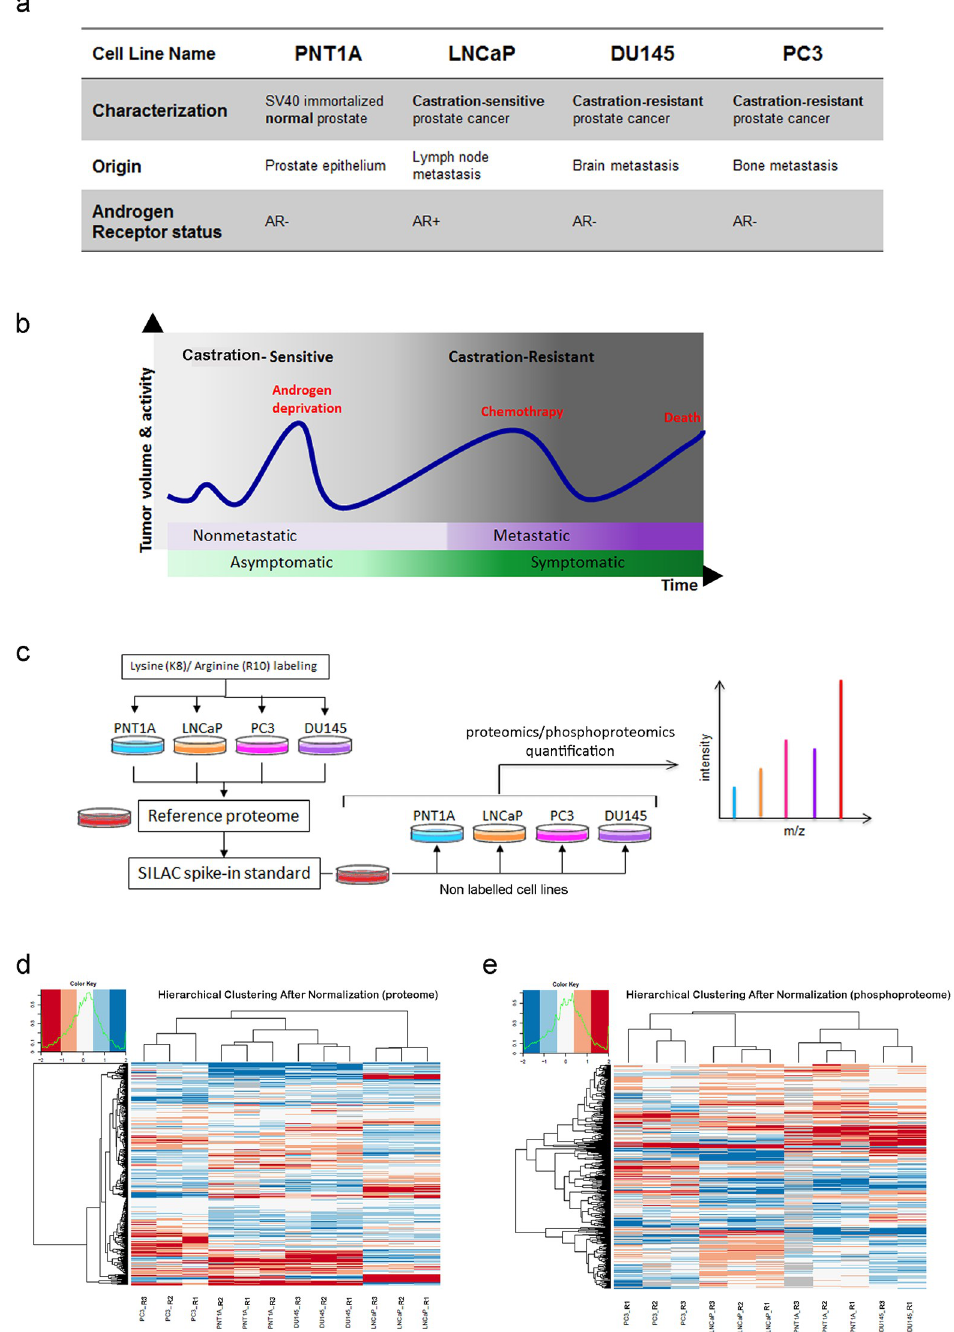
Fig 1. Overall overview of our study. (A) Prostate cell lines used in the present study. AR: Androgen Receptor. (B) Prostate cancer progression over time, from localized asymptomatic castration-sensitive to metastatic castration-resistant disease. (C) SILAC Cell line culture preparation, Spike-in and Mass Spectrometry analysis of the proteomes and phosphoproteomes. Figure adapted from [19] (D) Hierarchical clustering of the proteomes and (E) phosphoproteomes normalized expression data in the four cell lines.